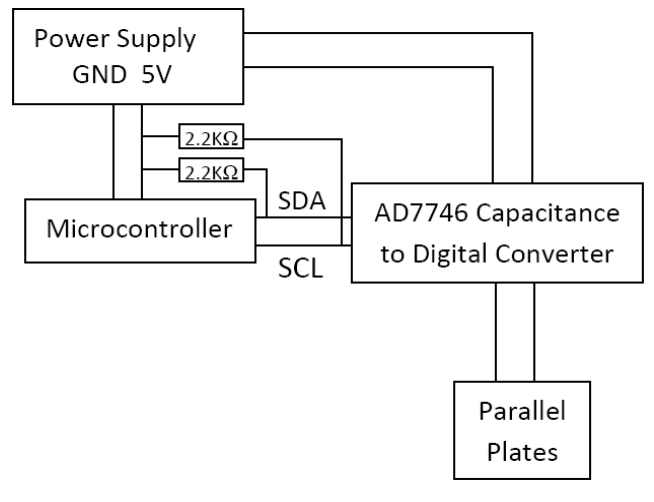
Figure 4. Circuit diagram showing measurement of displacement.